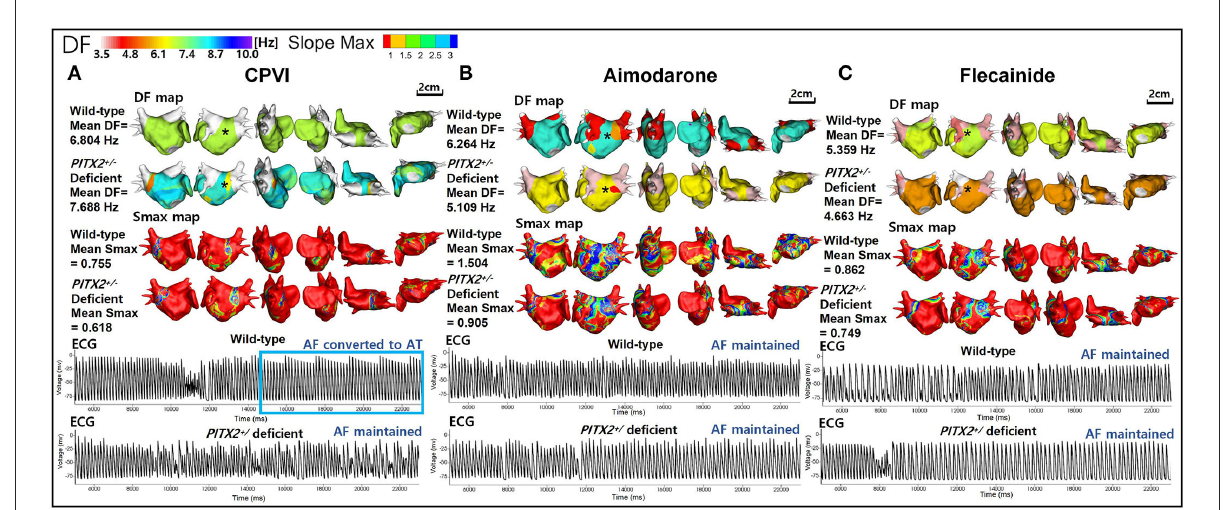
FIGURE3 Wave-dynamic change after a virtual CPVI and AADs. (A) The ECGs were obtained at the black * sites in the DF maps and indicate that AF converted to AT after the CPVI during a wild-type condition was still maintained during a PITX2 + / − deficient condition. (B) The ECGs were obtained at the black * sites in the 3D DF maps and indicate that AF was still maintained after high dose amiodarone under both wild-type and PITX2 + / − deficient backgrounds. (C) The ECGs were obtained at the black * sites in the DF maps and indicate that the AF was still maintained after high dose flecainide under both wild-type and PITX2 + / − deficient backgrounds. DF, dominant frequency; Smax, the maximal slope of the restitution curves; CPVI, complete pulmonary vein isolation; AF, atrial fibrillation; AT, atrial tachycardia; ECG, electrocardiogram; PITX2 , paired-like homeodomain transcription factor